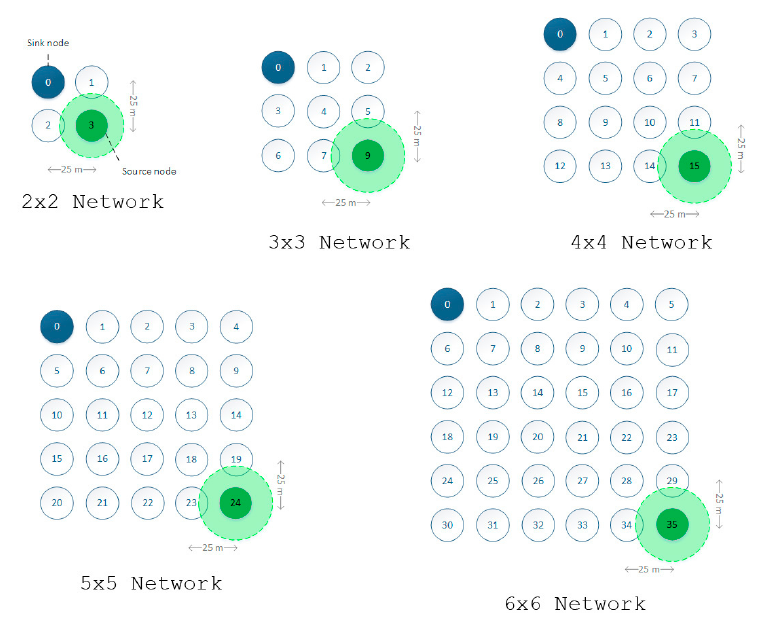
Figure 7 . Simulation scenarios. Figure 7. Simulation